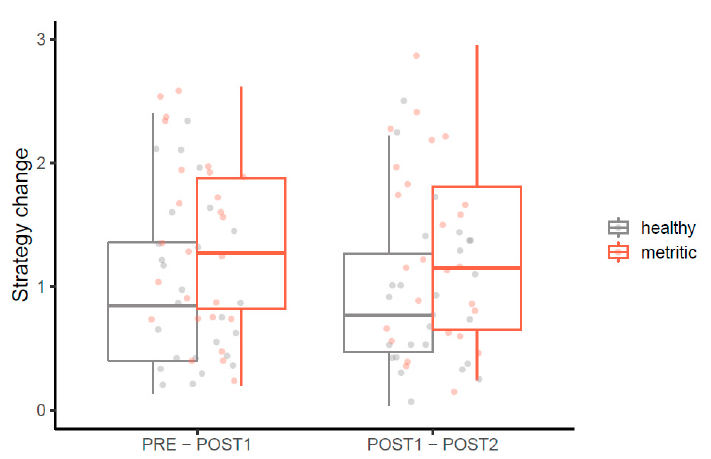
Figure 2. Magnitude of change in competition strategies between observation periods (PRE: d − 6 to − 1 prepartum, POST1: d 1 to 3 postpartum, POST2: d 4 to 6 postpartum) for healthy ( n = 26) and metritic ( n = 26) cows. Competition strategies are defined in 2-dimensional space by asynchrony and competitiveness scores; the y -axis shows strategy change between observation periods, calculated as the distance between corresponding points. Compared to healthy cows, metritic cows showed a greater change in competition strategy from PRE to POST1 ( p = 0.06) and from POST1 to POST2 ( p = 0.04).